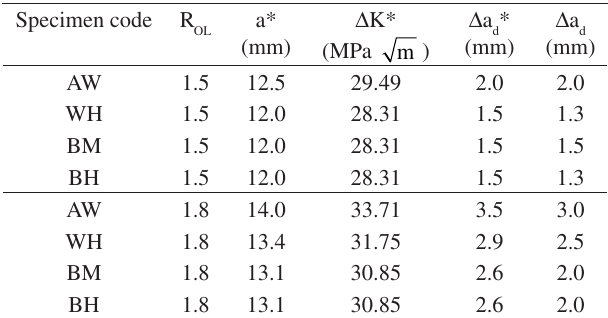
Table 3. Delay parameters ∆ a model. Specimen R Code